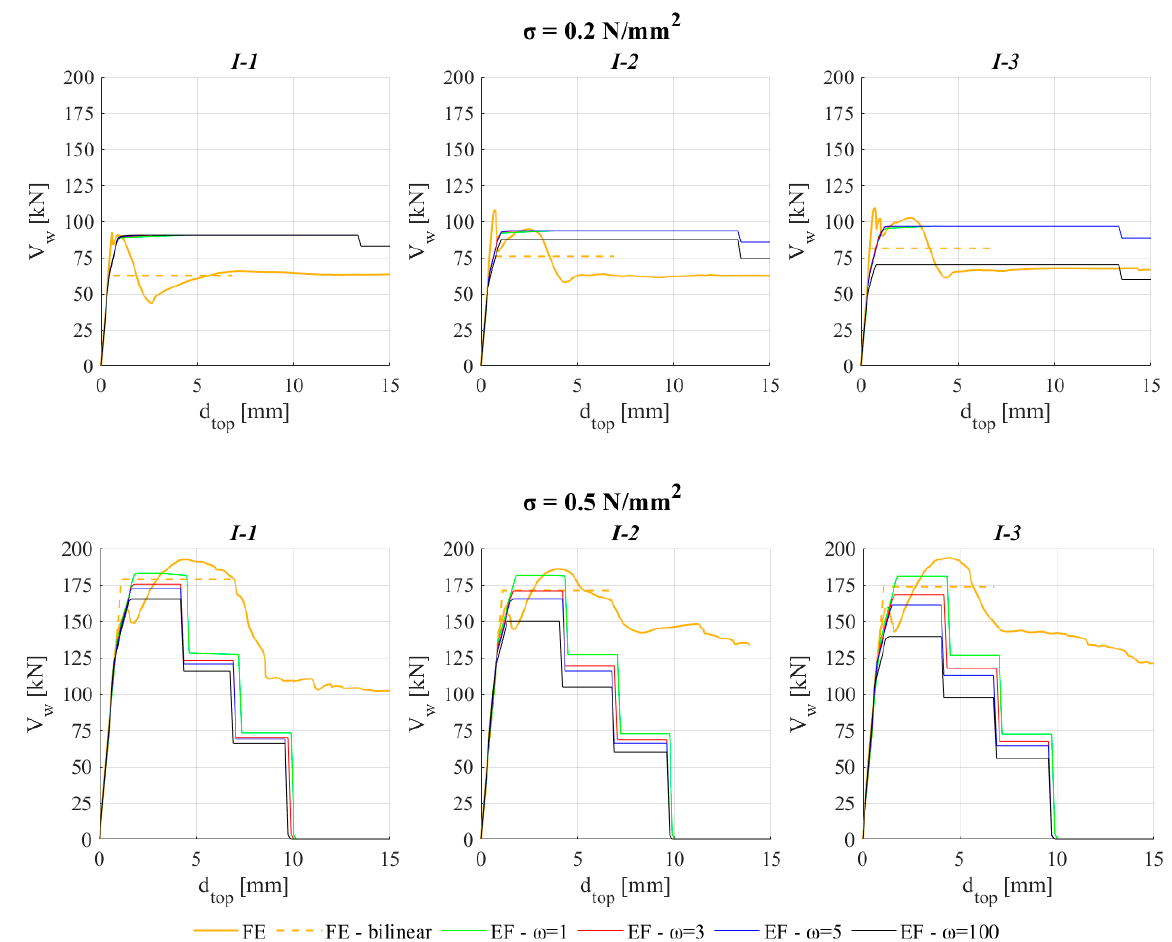
Figure 15. Comparison in terms of web’s base shear ( V w ) versus horizontal top displacement ( d top ) curve for some of the examined I-shaped 3D assemblies.